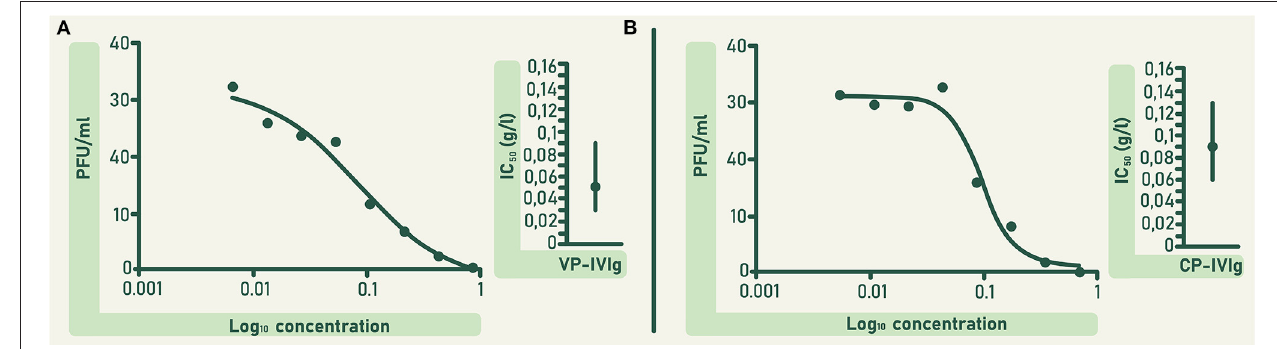
FIGURE 5 | In vitro neutralizing potency of VP-IVIg (A) and CP-IVIg (B) determined by PRNT. Dose-response curves are shown left and mean inhibitory concentrations of both formulations are shown right. IC 50 was calculated using a non-linear regression analysis in the GraphPadPrism 5 software. Vertical solid lines denote 95% confidence intervals for both